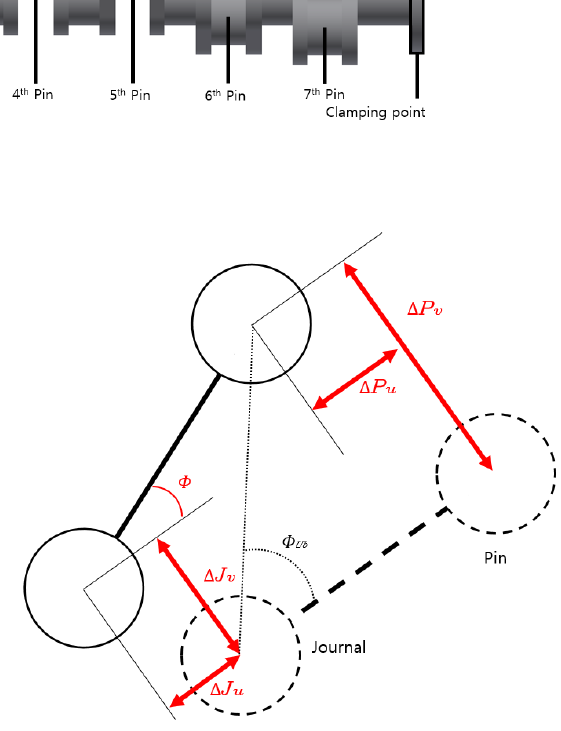
Figure 5. Change of angle error due to bending effect.